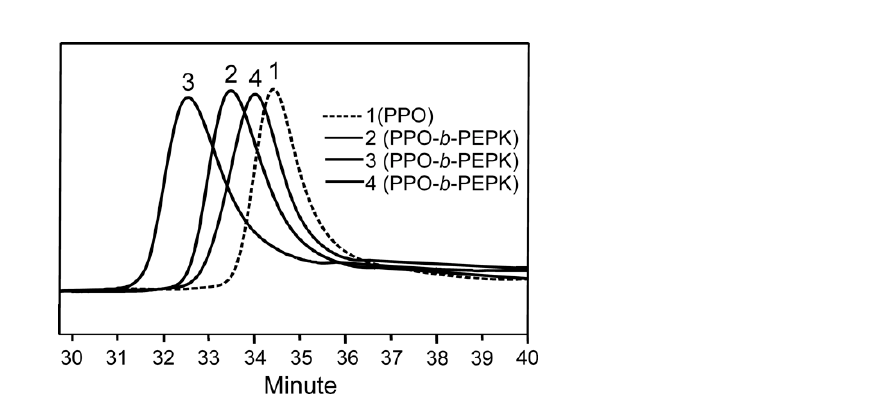
Figure 6. TGA ( A ) and DSC ( B ) curves of PPO- b -PEPK copolymer sample 2.